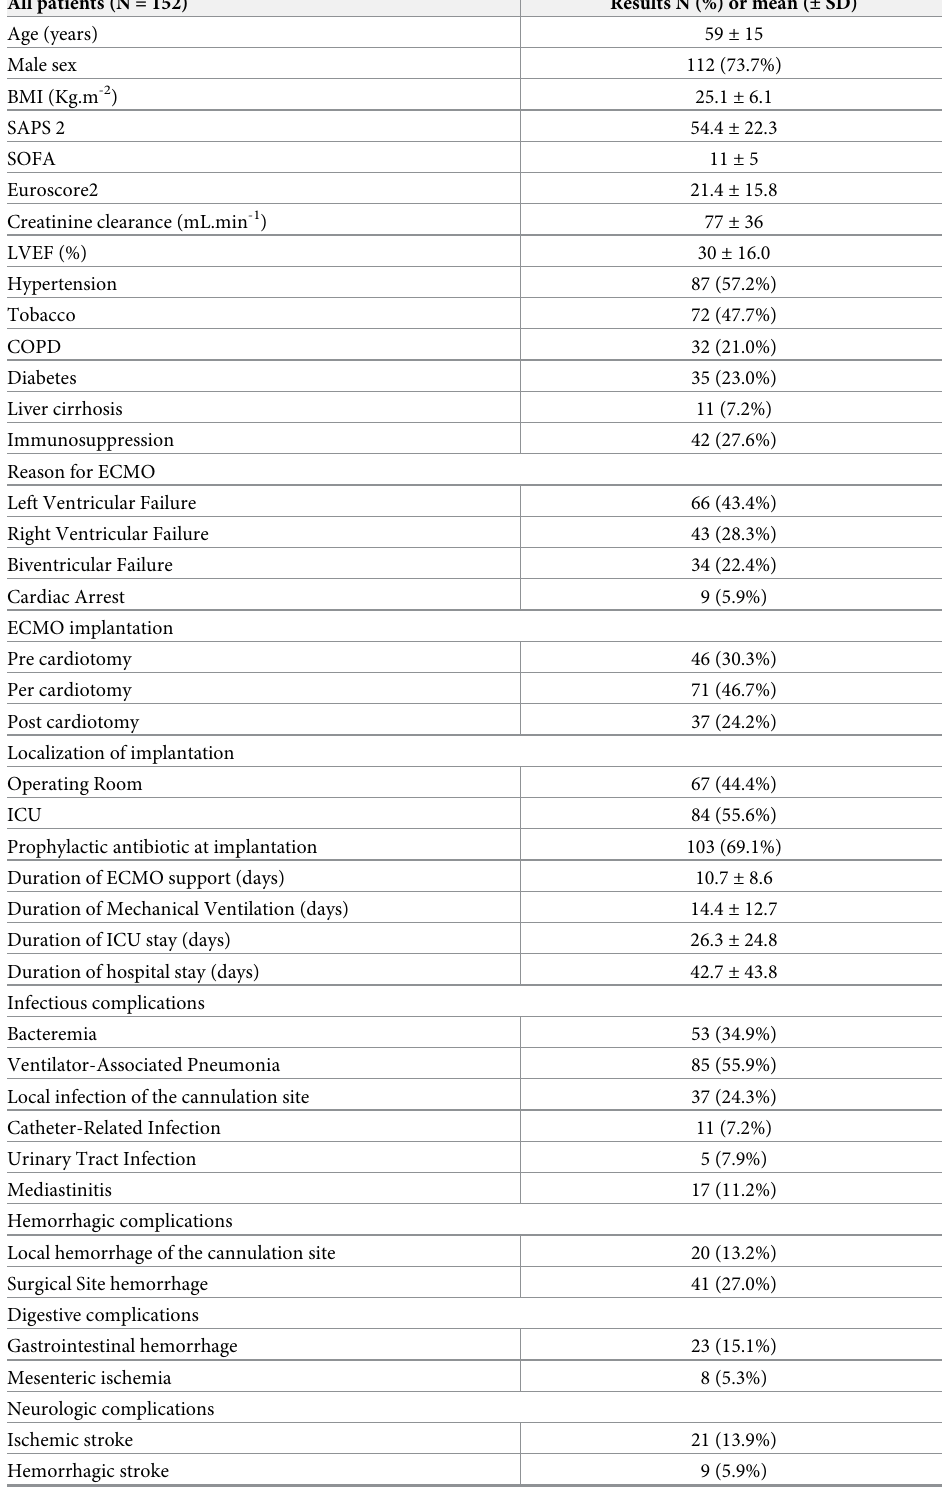
Table 1. Baseline characteristics. All patients (N =